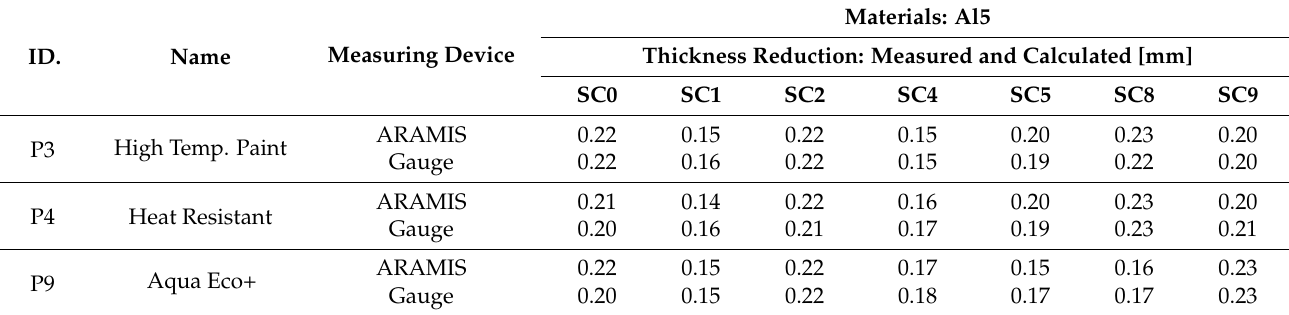
Table 11. Comparison of ARAMIS and thickness measurement results.